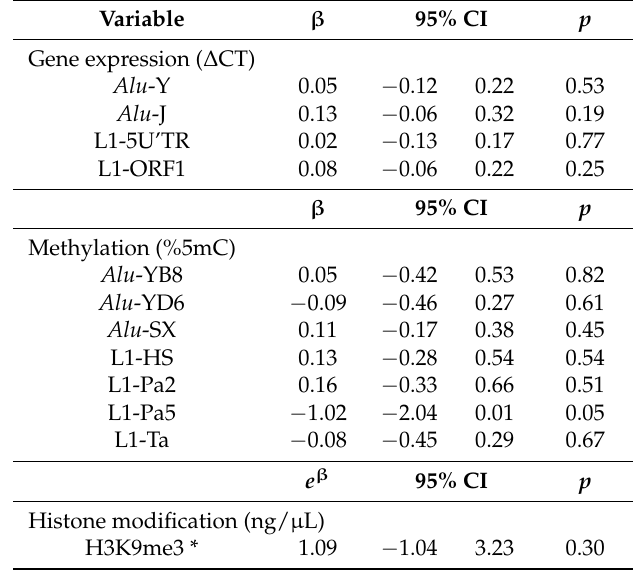
Table 2. Differences in gene expression, DNA methylation, and histone modification in peripheral blood lymphocytes between petrol station workers and control subjects. Variable β 95% CI Gene expression ( ∆